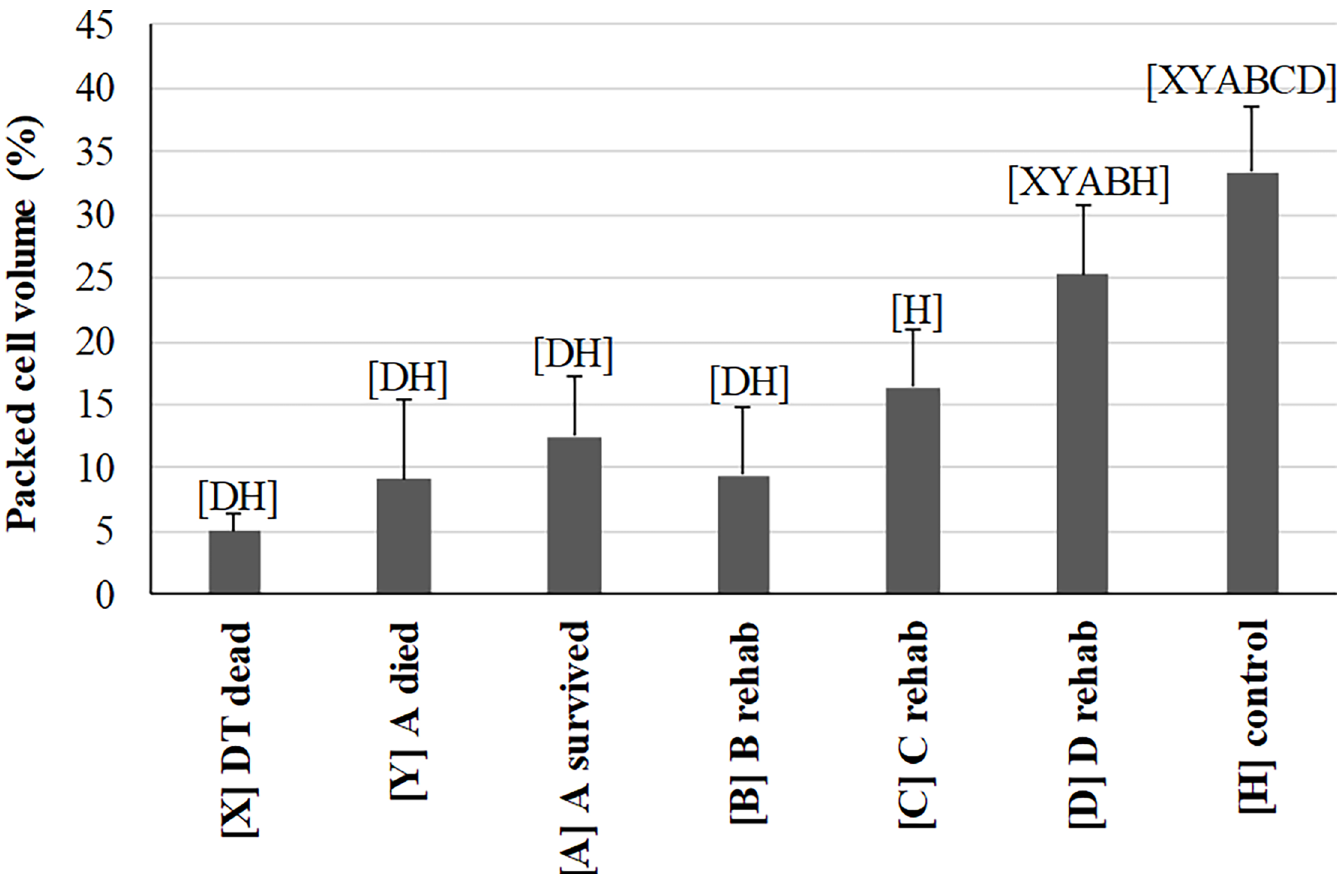
Fig 3. Comparison of packed cell volume (PCV) measured in debilitated loggerhead sea turtles (DTs) before and during rehabilitation and compared to healthy loggerhead turtles (means and one standard deviation). Lines represent an individual turtle through rehabilitation. Each turtle group on the x-axis was significantly different (p < 0.05 or p < 0.00883 for repeated measures) from groups represented by letters above data. Sample size for each group: 2 [X], 10 [Y], 11 [A], 7 [B], 6 [C], 9 [D], 69